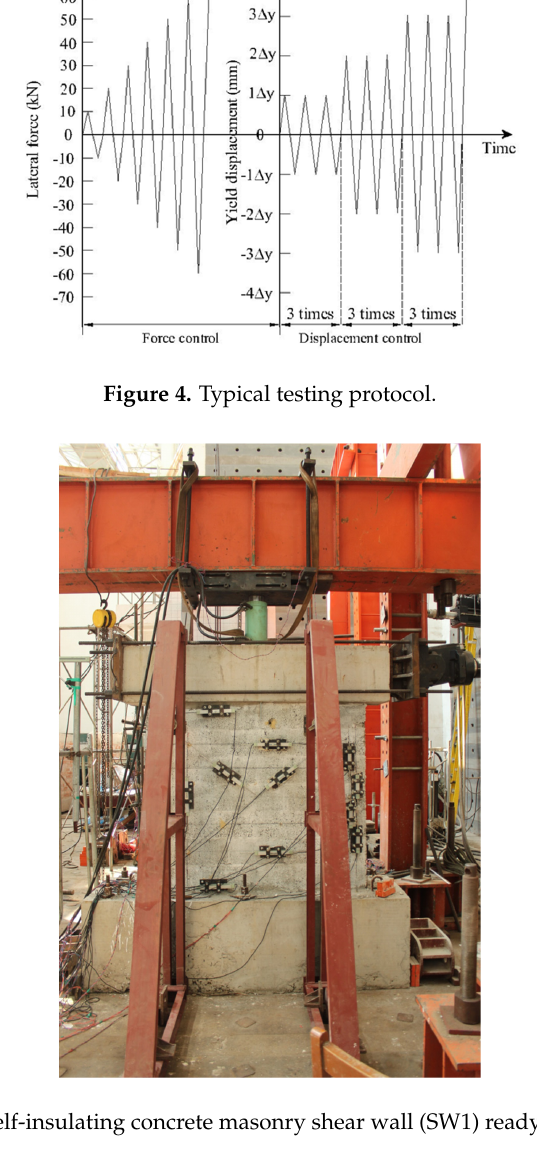
Figure 5. Self ‐ insulating concrete masonry shear wall (SW1) ready for testing.